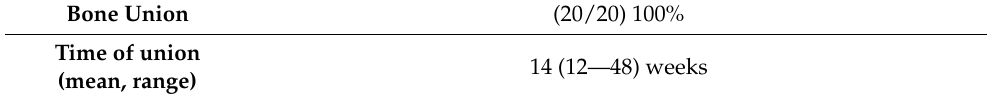
Table 2. Pre-operative and last follow-up mean values with standard deviation and ranges. Bone Union (20/20) 100% Time of union 14 (12—48) weeks (mean, range) Complications One delayed consolidationOne wound dehiscence Pre-op Post-op * p -value VAS 7.9 ± 1.4 (5–10) 2.2 ± 1.1 (1–4) 0.002 § AOFAS 23.2 ± 11.9 (7–44) 68.6 ± 8.9 (50–78) FFI 70 ± 13 (54–88) 29 ± 14 (15–50) 0.002 § SF-36 29.2 ± 3 (23–33) ADTA 83.0 ◦ ± 12.0 ◦ (71–102) † - TTA - CTTA 97.5 ◦ ± 7 ◦ (90–108) † - HAA 20 ◦ ± 5 ◦ (14–29) † 9 ◦ ± 5 ◦ (5–13) ‡ -